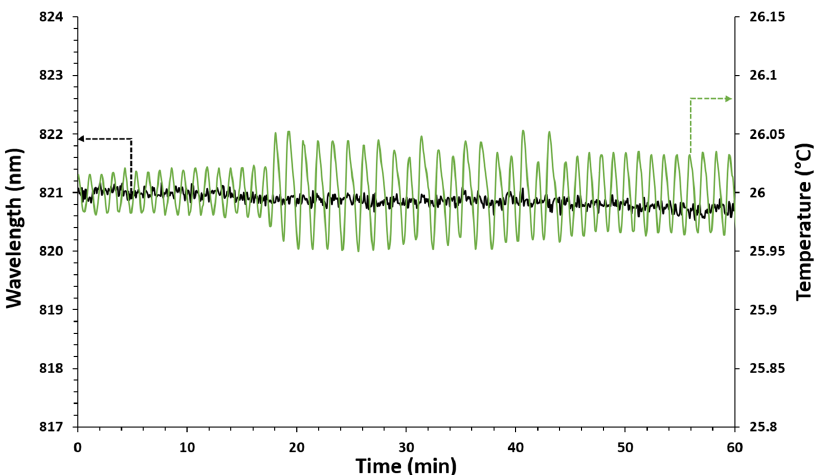
Figure 7. Stability of the system at a fixed temperature. Green line: temperature values measured by the thermistor inside the cell. Black line: LMR wavelength during the test.